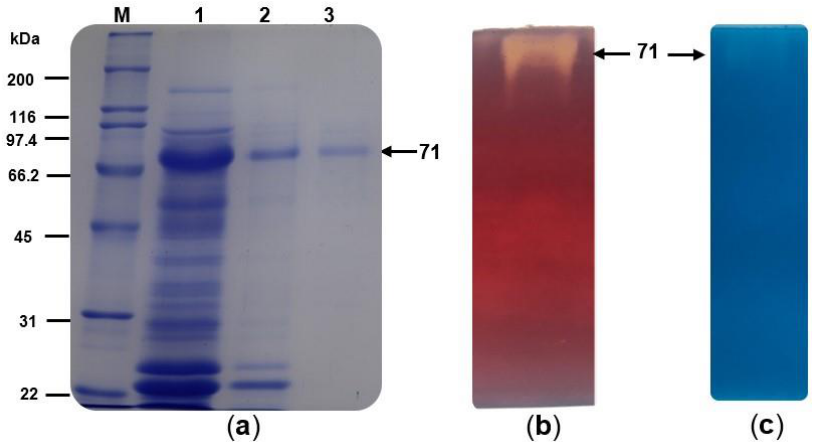
Figure 2. Purification and zymogram analysis of TtCel7A on 10% SDS-PAGE. ( a ) A 10% SDS-PAGE analysis of purified TtCel7A. Lanes M: molecular weight standard; 1: crude extract; 2: anion exchange chromatography fractions; 3: purified TtCel7A. ( b ) Zymogram analysis of TtCel7A using 1% CMC as substrate. ( c ) Zymogram analysis of TtCel7A, using 1% RBB-X as substrate.